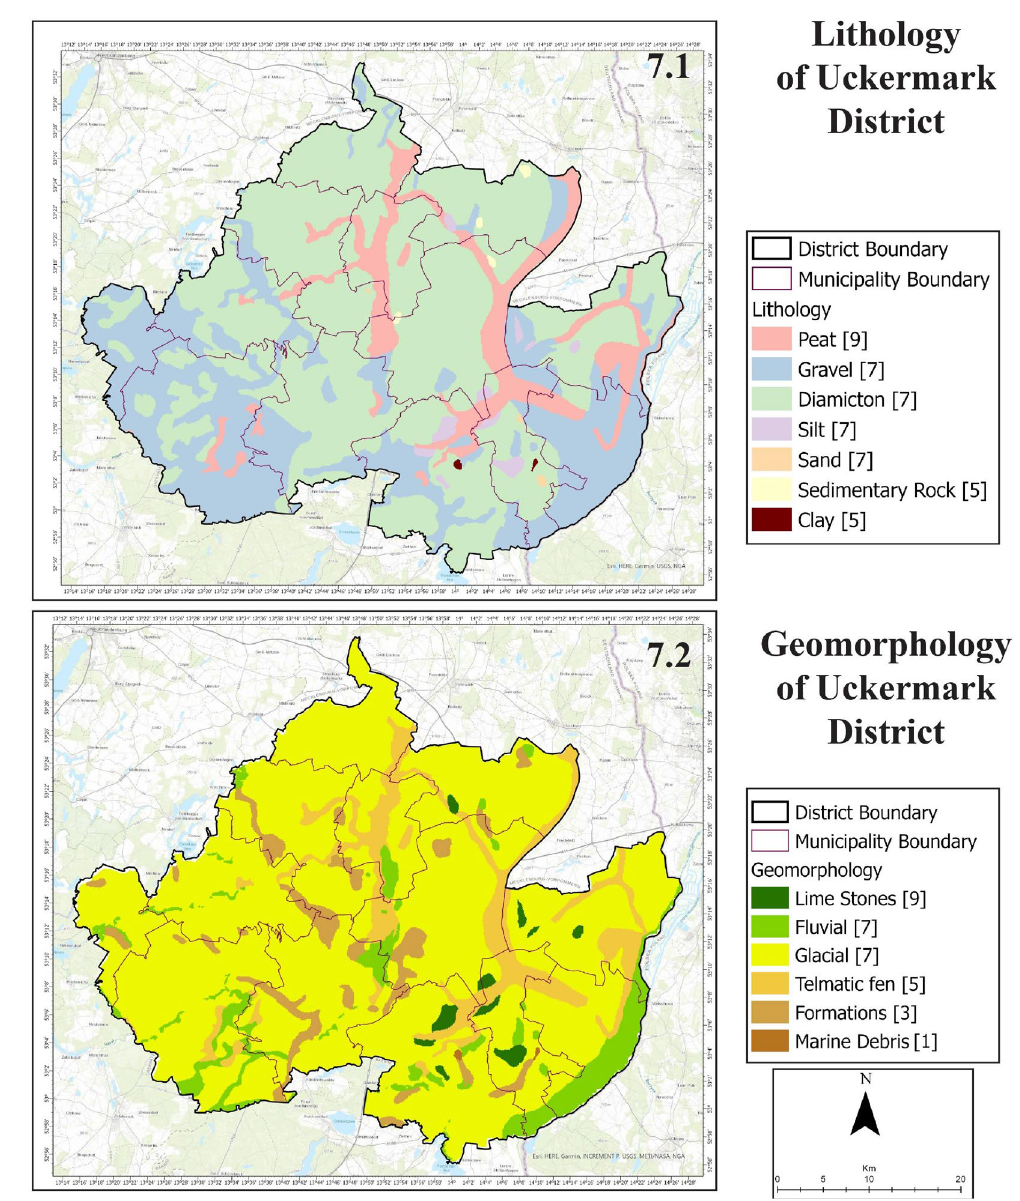
Figure 7. Lithology (7.1) and geomorphology (7.2) of Uckermark